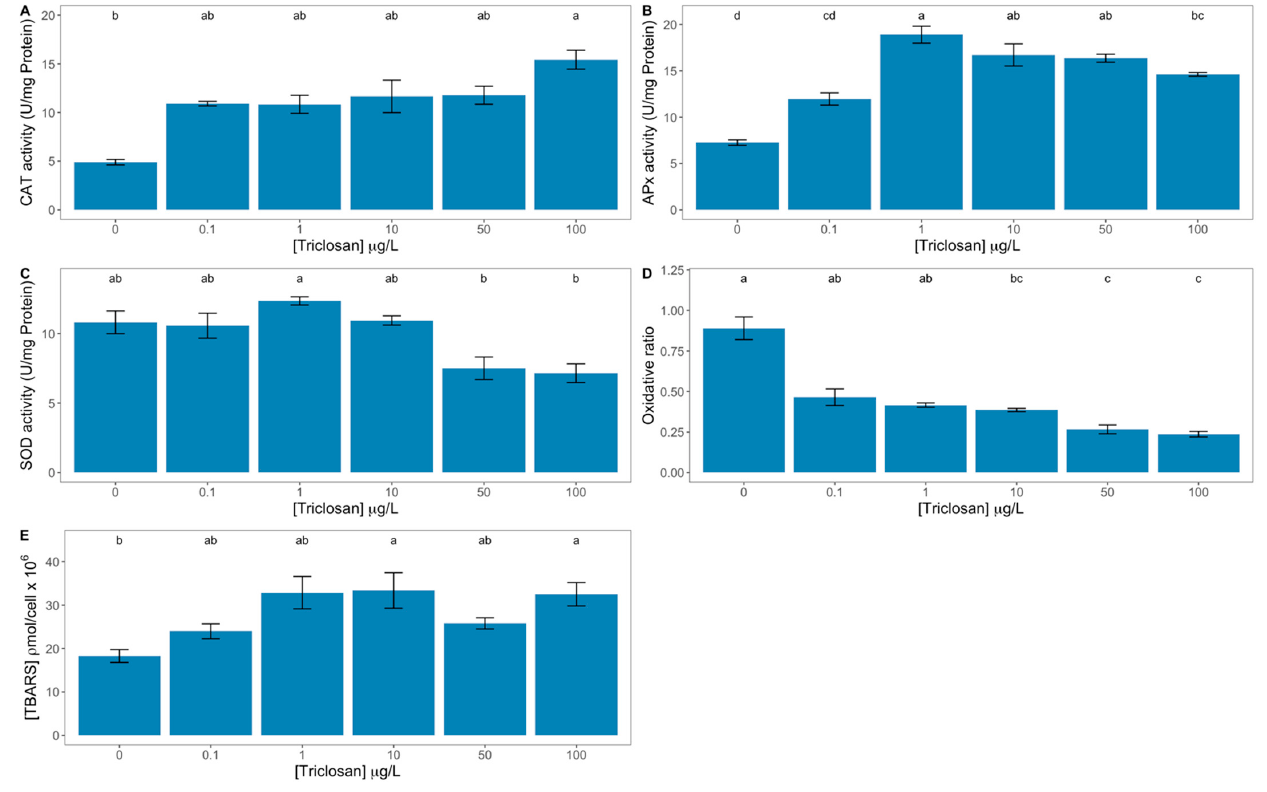
Figure 8. Triclosan-exposed Phaeodactylum tricornutum cultures oxidative stress biomarkers [catalase activity (CAT, A ), ascorbate peroxidase activity (APx, B ), superoxide dismutase (SOD, C ), and thiobarbituric reactive substances (TBARS, E )] and oxidative ratio ( D ) (average ± standard error, n = 3; different letters denote significant differences between triclosan treatments at p < 0.05).